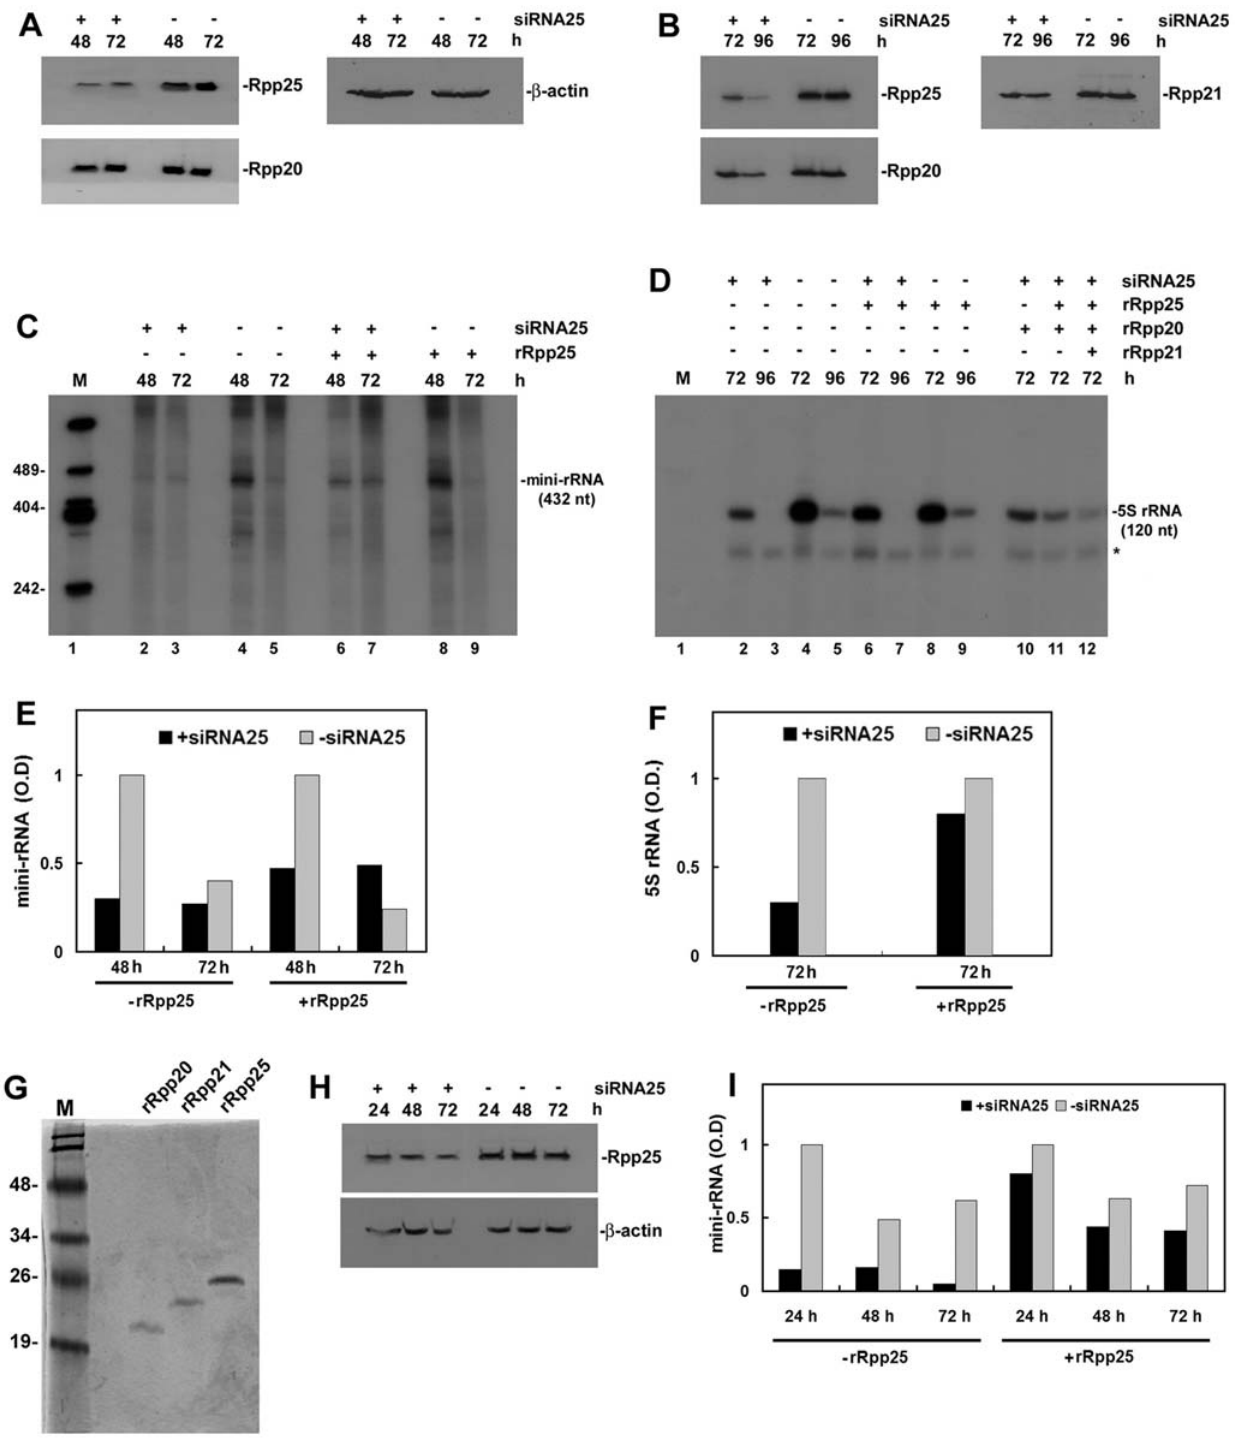
Figure 3. Pol I transcription deficiency can be restored by a recombinant Rpp25 protein. A. HeLa cells were transfected with a plasmid expressing siRNA25 or mock transfected (see Materials and Methods), whole extracts were then prepared from cells at 48 and 72 h after transfection and examined for Rpp25, Rpp20 and b -actin by Western blot analysis. Positions of proteins are depicted. B. Same as in A but transfection was for 72 and 96 h and proteins tested were Rpp25, Rpp20 and Rpp21. C. Reconstitution assays of transcription of the mini-rRNA gene in extracts described in A were performed in the absence or presence of recombinant Rpp25 protein. The resulted 432-nt mini-rRNA was analyzed as in Figure 1C. Exposure time was for 96 h. D. Reconstitution of a human 5S rRNA gene transcription in extracts described in B in the absence or presence of recombinant Rpp25 protein. As controls, recombinant Rpp20 and Rpp21 proteins were used. The resulted 120-nt 5S rRNA was analyzed as in Figure 1C. Asterisk indicates endogenous tRNA labeled with radioactive nucleotide. E. The 432-nt mini-rRNA bands seen in C were quantitated and the optical density (in arbitrary units) was plotted. F. The 120-nt 5S rRNA bands seen in D were quantitated and the optical density (in arbitrary units) was plotted. G.